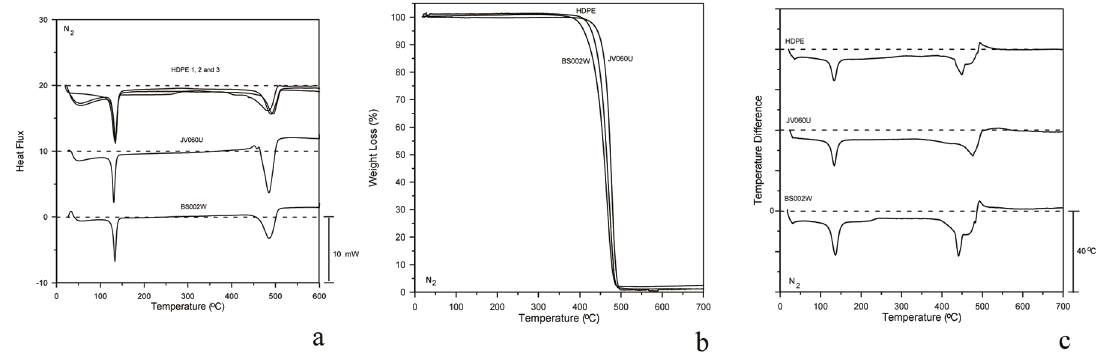
Figure 1. Thermal degradation in an inert atmosphere of commercial (BS002W and JV060U) and laboratory (HDPE) high density polyethylene: a) Differential scanning calorimetry, b) Thermo gravimetric analysis, c) Differential thermal analysis. Table 3. In situ polymerization results and properties of polymers produced Sample